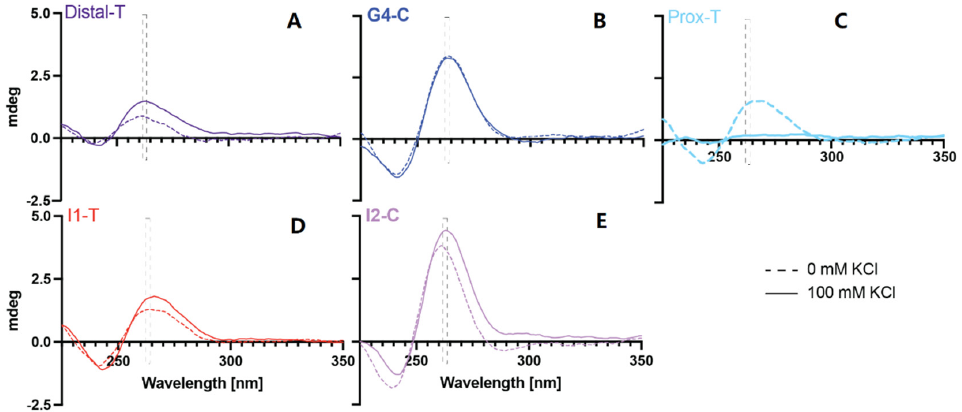
Figure 2. G4 formation within GC-rich MYC sequences. G4 formation was monitored by electronic circular dichroism (ECD) for the five putative G4-forming DNA sequences—Distal-T ( A ), G4-C ( B ), Prox-T ( C ), I1-T ( D ) and I2-C ( E ). The sequences were annealed in the absence (dashed lines) or presence (solid lines) of 100 mM KCl; spectra were recorded from 225 to 350 nm. Only G4-C and I2-C (both bold) demonstrated parallel G4 formation as noted by maximal Cotton effects in the 262–264 nm range (highlighted in each frame by the dashed box).